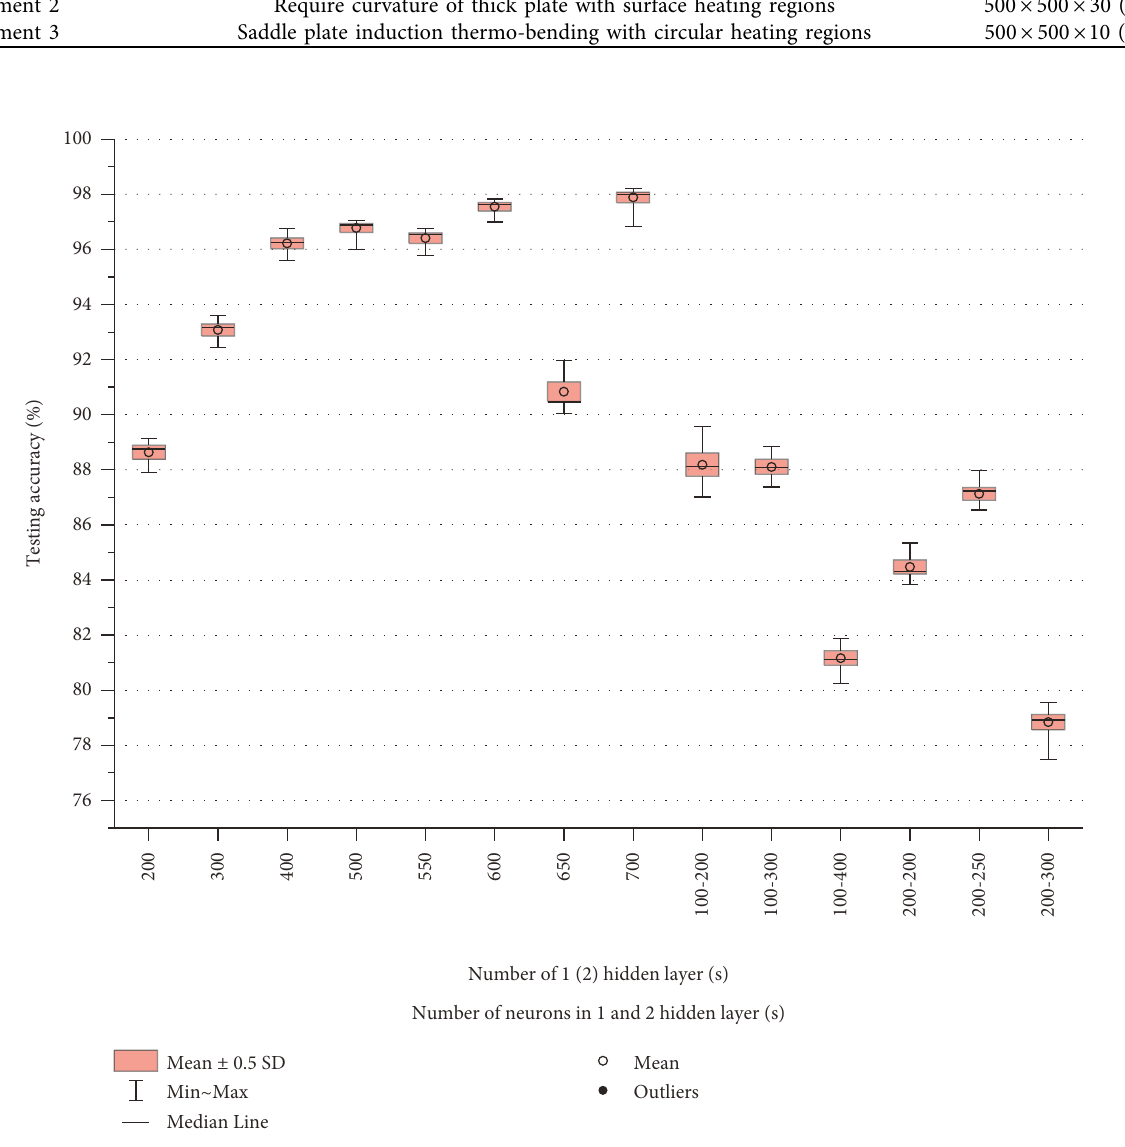
Figure 6: Predicted induction heating area position accuracy